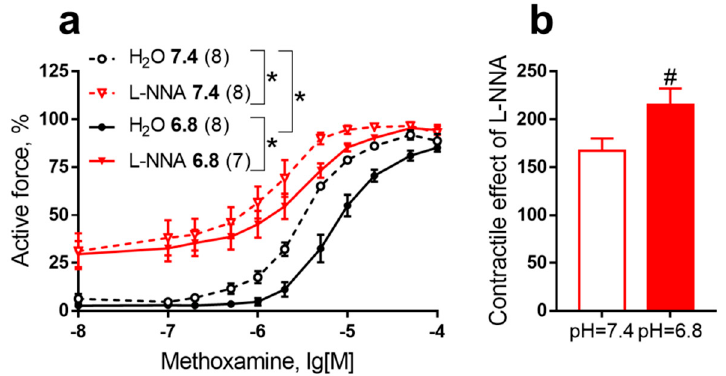
Figure 1. Acidosis potentiates the functional contribution of eNOS to the regulation of vascular tone in the early postnatal period. In 10–15-day old rat pups, extracellular acidosis (pH 6.8) reduces contractile responses of saphenous arteries to the α 1 -adrenoceptor agonist methoxamine by increasing the anticontractile influence of NO. ( a ) Concentration-response relationships to methoxamine in the presence of the NO-synthase inhibitor L-NNA (100 µM) or its vehicle (H 2 O, 50 µL) at pH 7.4 and pH 6.8. The numbers in brackets indicate the number of animals. * p < 0.05 (two-way ANOVA with Tukey’s multiple comparisons test). ( b ) Contractile effect of L-NNA at pH 7.4 and pH 6.8. # p < 0.05 (unpaired Student’s t -test).